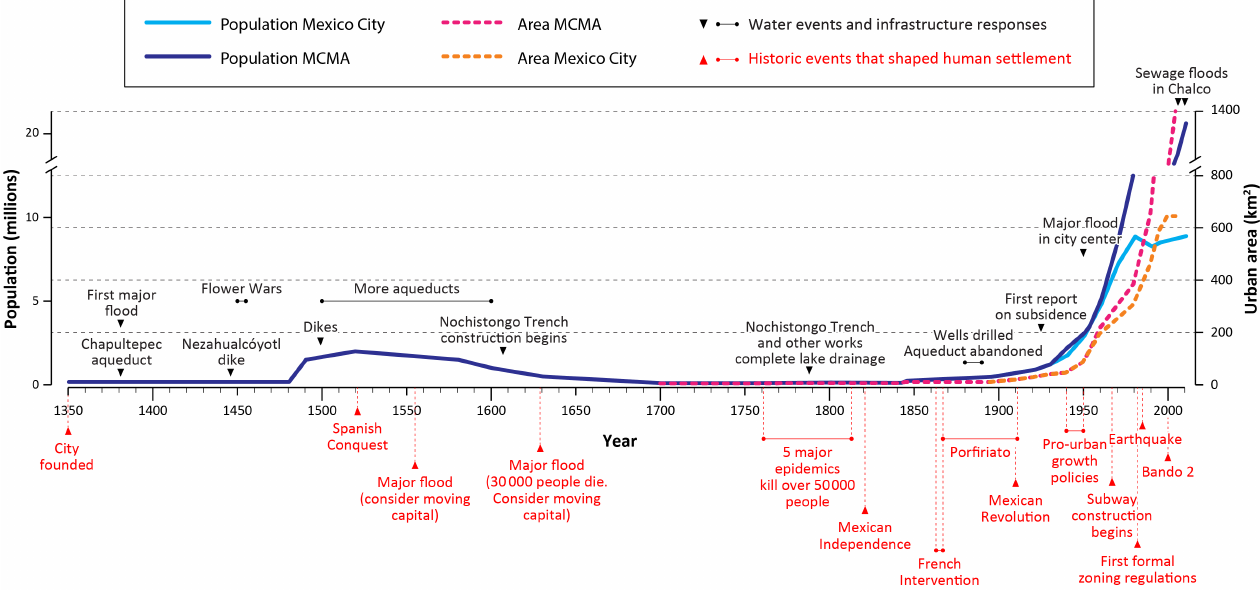
Fig. 3 . Urban area and population growth in Mexico City proper and the larger metropolitan area (MCMA is Mexico City Metropolitan Area), 1325 to present, with significant historical events and adaptation decisions. Note: population estimates for the metropolitan area represent the population in the Basin of Mexico until 1521. Separate population data for Mexico City and the MCMA were not available until the 1960s. Note: break in scale for metropolitan area population and urban area in the 1990s,